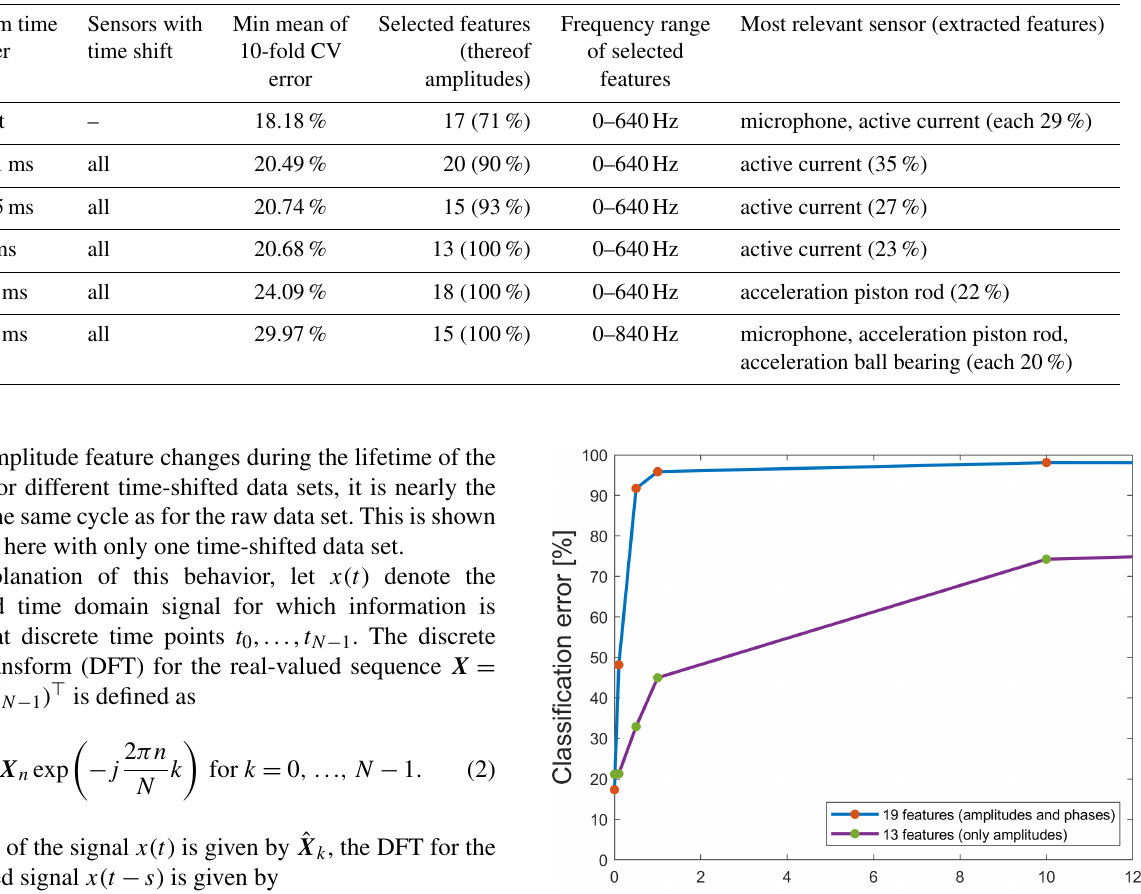
Table 3. Cross-validation error for the 2kHz raw data set and 2kHz data sets with different time shifts with BFC as extractor and RFESVM as selector.